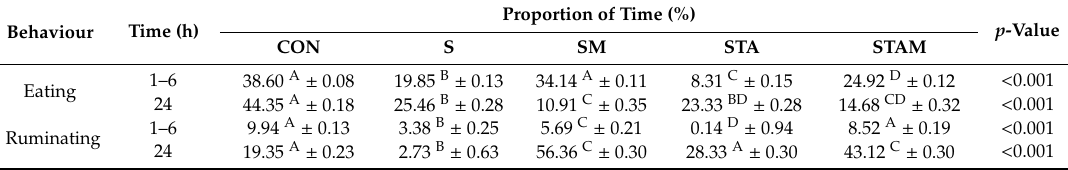
Table 6. Proportion of time spent eating and ruminating ( ± SE) by heifers in each treatment group at 1–6 h and 24 h